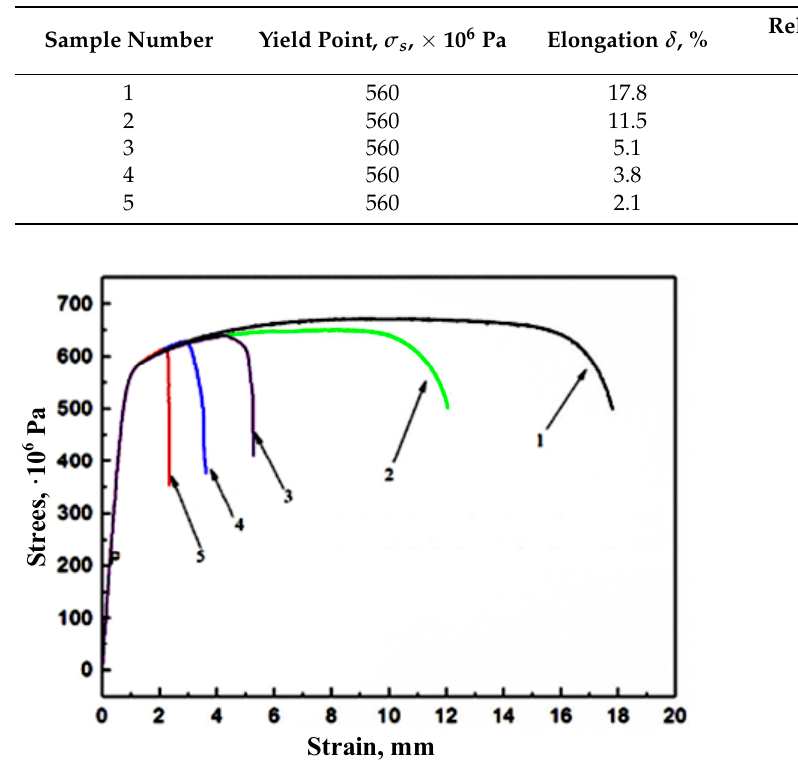
Figure 8. Tension diagram of samples of pipeline steel X80 in air and in the presence of external hydrogen when tested with a low strain rate (2 × 10 − 5 ) [34]. hydrogen when tested with a low strain rate (2 × 10 − 5 )